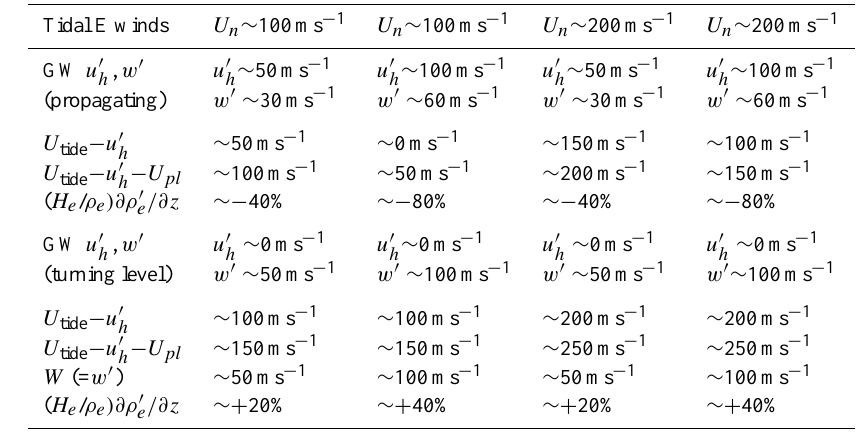
Table 6. Estimated tidal and GW parameters at the bottomside F layer based on SpreadFEx measurements and associated modeling. The center row shows parameters assuming an eastward tidal motion and a single westward- and vertically-propagating GW in its upward phase. The bottom row assumes the same tidal motion, but now with a westward-propagating GW approaching a turning level, with m = > 0, largely ∼ 0), and essentially no induced electron density gradients. The same GW imagined in the center vertical motions (w’ ∼ 50 or 100ms − 1 , u 0 h row could also contribute to the electron density gradient in the bottom row without overcoming the enhanced vertical motion due to the GW approaching its turning